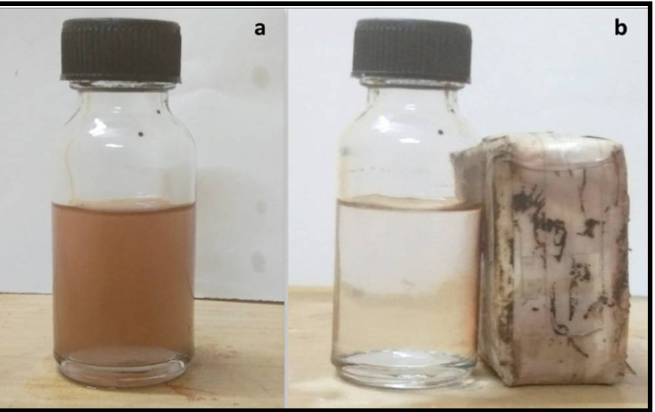
Figure 5. Magnetic behavior of the MHAP nanoparticles ( a ) suspension of nanoparticles and ( b ) MHAP nanoparticles attracted toward the magnet.